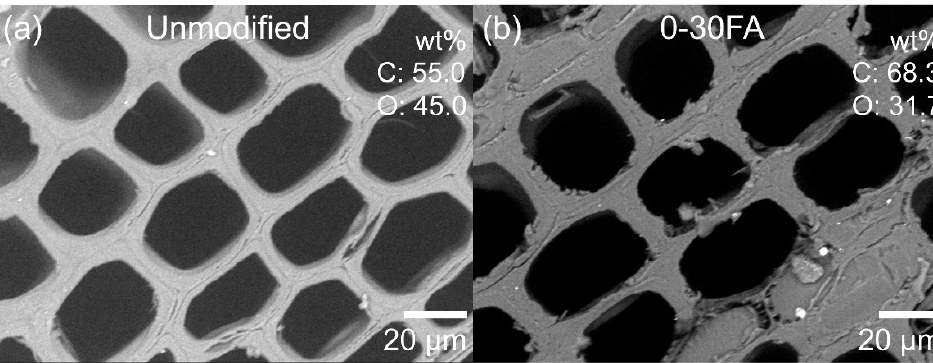
Figure 4. Low-vacuum SEM images and elemental composition analyzed by EDX mapping of cross-sectioned earlywood samples: ( a ) unmodified and ( b ) modified specimens (0-30FA).